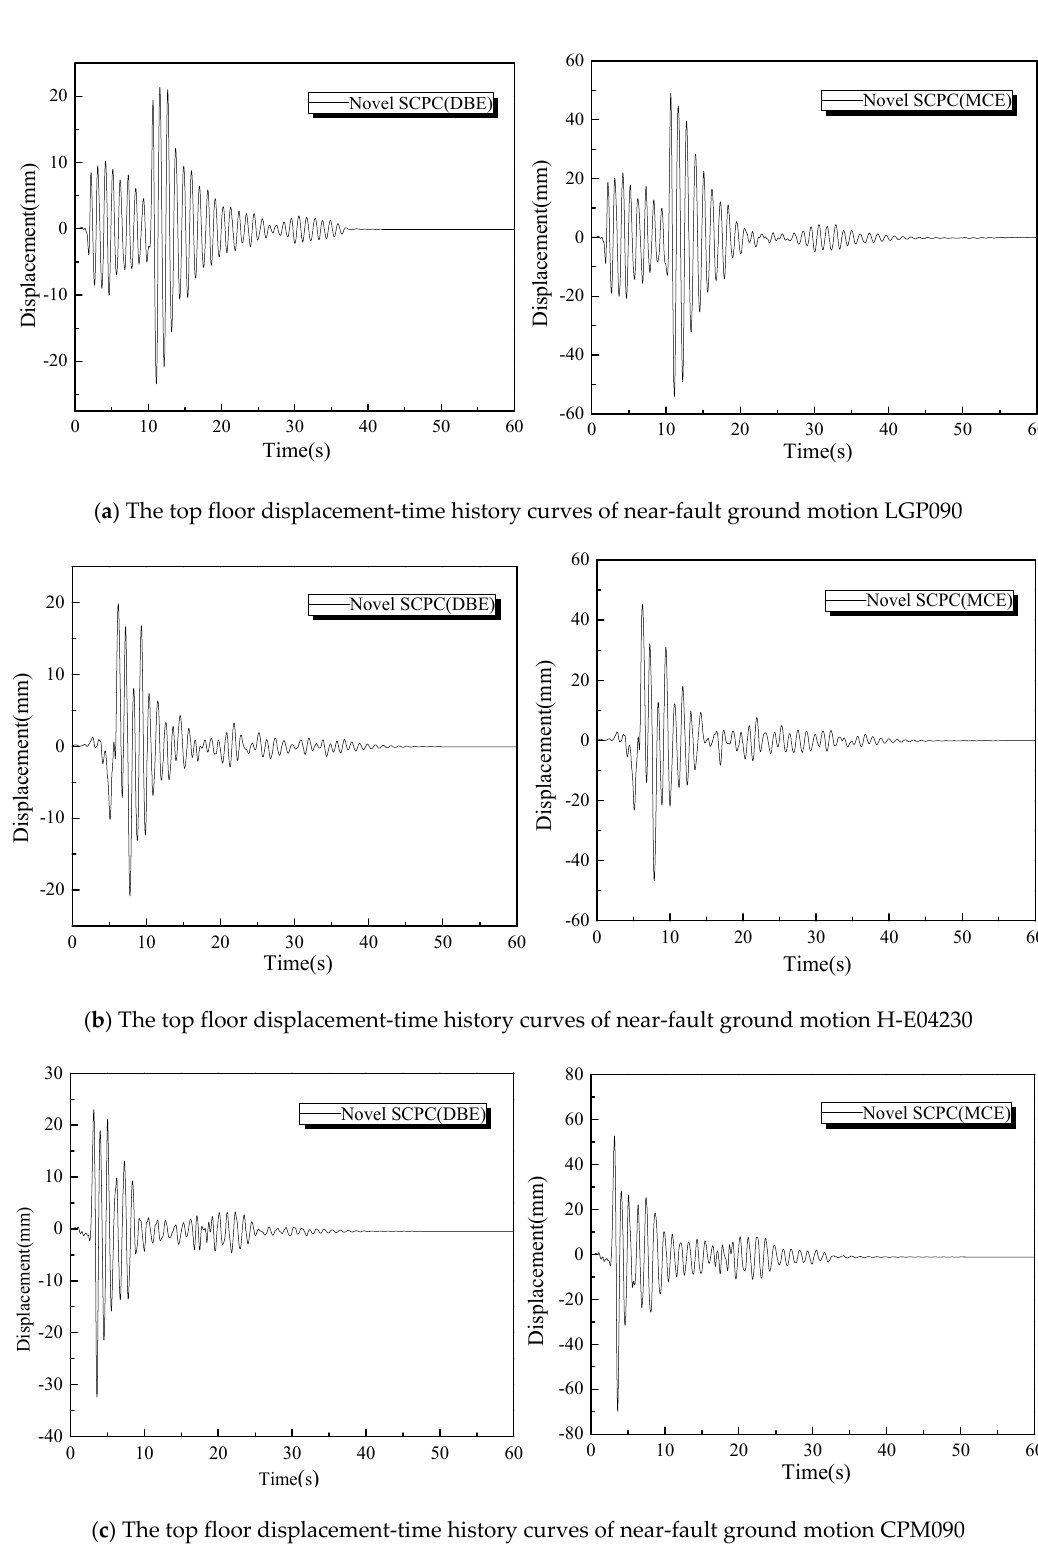
Figure 13. Time-history curves of top floor displacement-time history curves under design basis earthquake (DBE) and maximum considered earthquake (MCE). Table 2. Maximum top floor displacements under 21 ground motions.